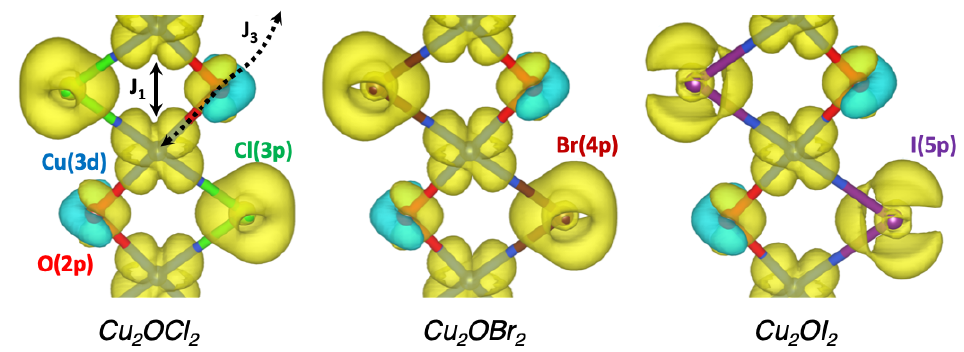
Figure 6. Spin density for the AFM ground state of Cu 2 OCl 2 , Cu 2 OBr 2 and Cu 2 OI 2 . The isovalue is set to 0.017 electron/Å 3 , up and down regions of the spin density are evidenced in transparent yellow and cyan, respectively. Blue, red, green, brown and violet spheres indicate Cu, O, Cl, Br and I atoms, respectively. The FM J 1 and AFM J 3 couplings are